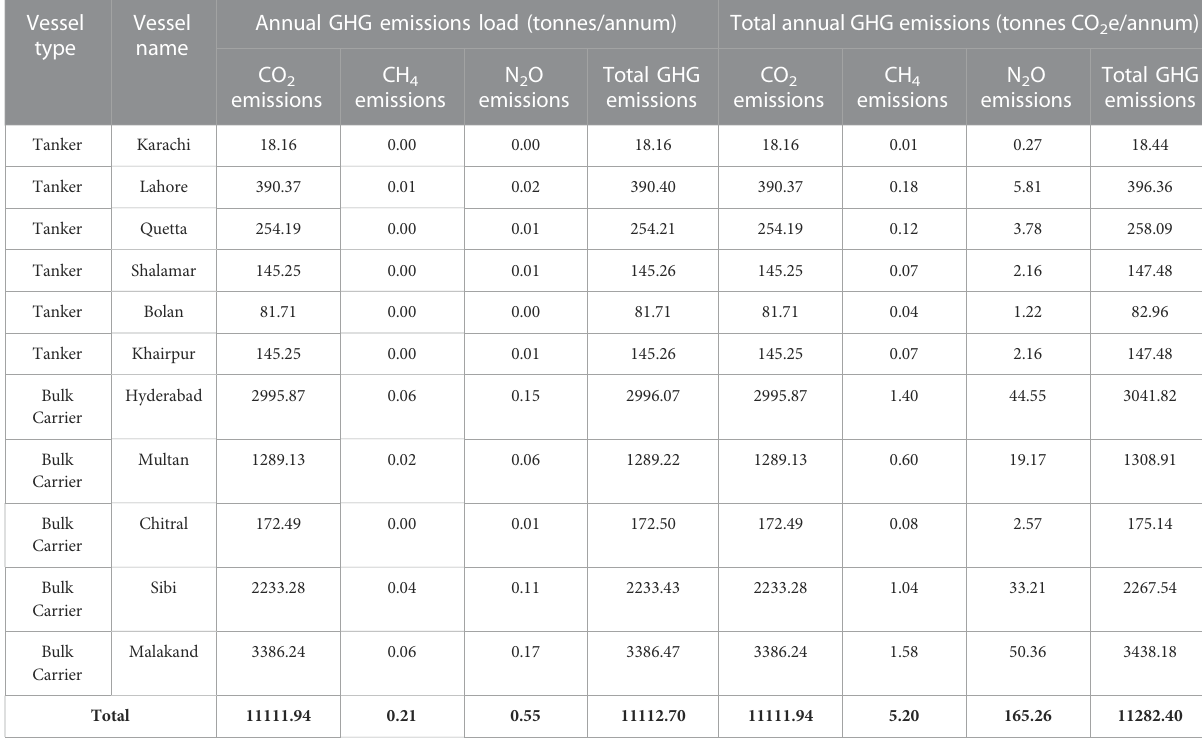
TABLE 10 Breakdown of total GHG Emissions from PNSC fl eet based on fuel consumption of MGO. Vessel